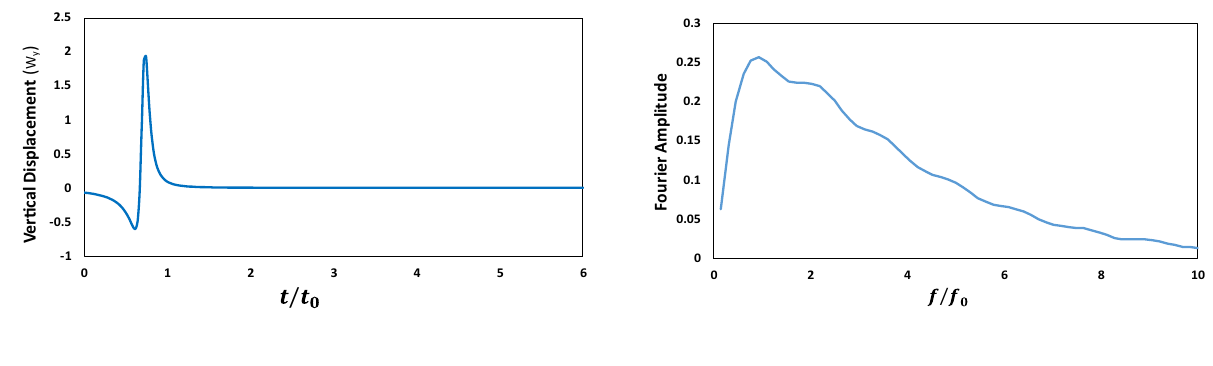
Fig. 2 Time history of vertical displacement and Fourier amplitude of R-wave from a solution of Lamb’s problems (dt = 0.025 s) Fig. 3 A view of R-wave propa- gation within the model for d/a = 1.5